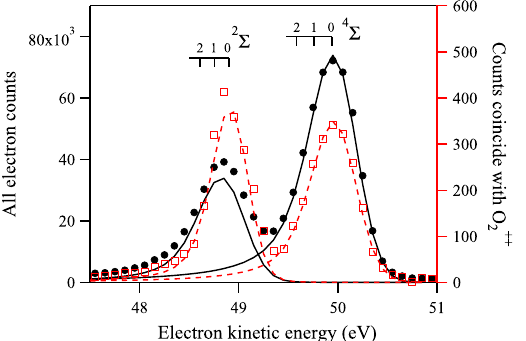
Figure 1. O 1s − 1 electron energy spectra of O 2 recorded at 593.4 eV photon energy. The total experimental electron energy spectrum is represented by solid circles and it is fitted by solid lines. The partial electron energy spectrum constructed from photoelectrons arriving in coincidence with ++ O and it is fitted by dashed lines. Two main